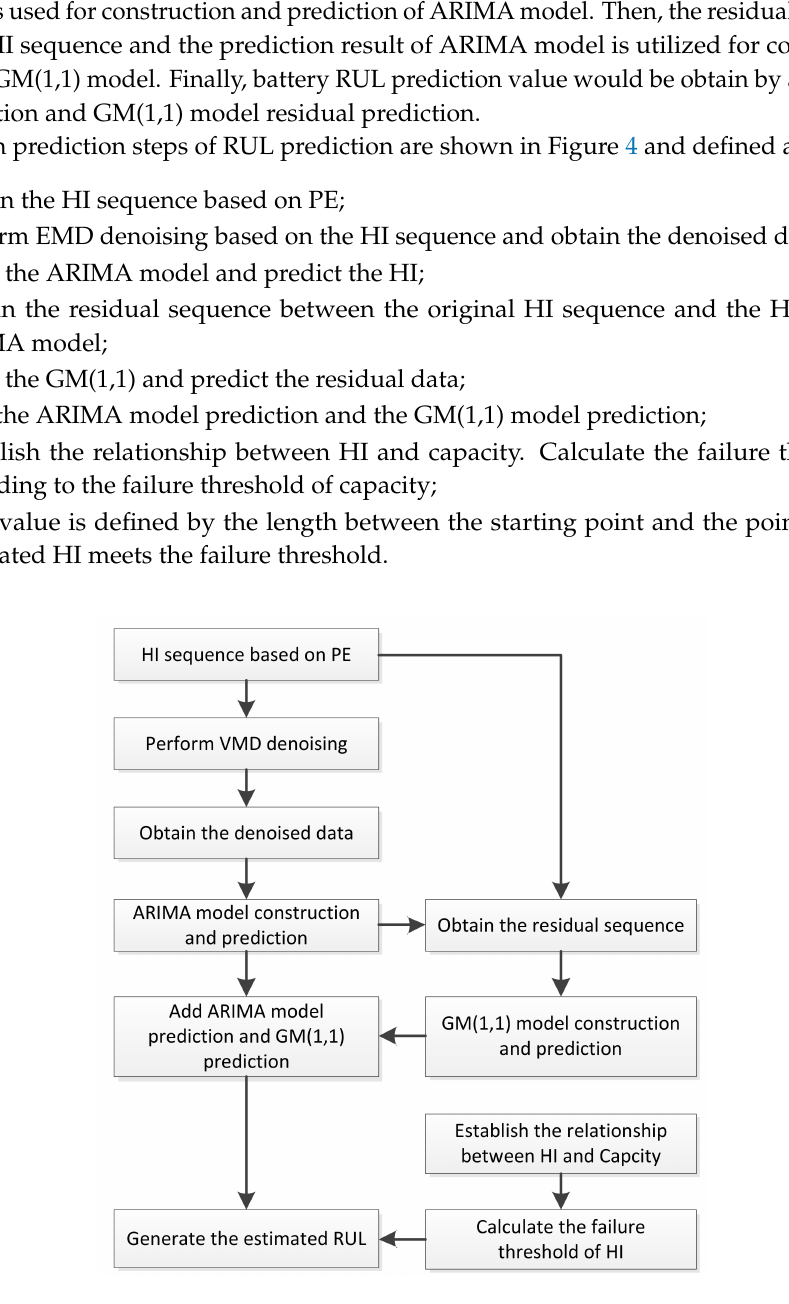
Figure 4. Framework of battery remaining useful life (RUL)